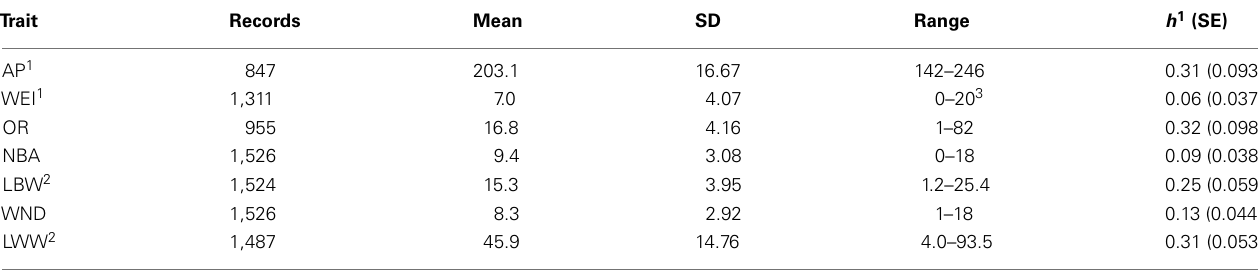
Table 3 | Mean and SD of phenotypic measurements in a LDY